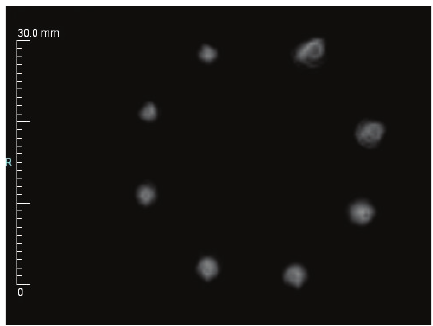
Figure 10: Contrast resolution reflection results.